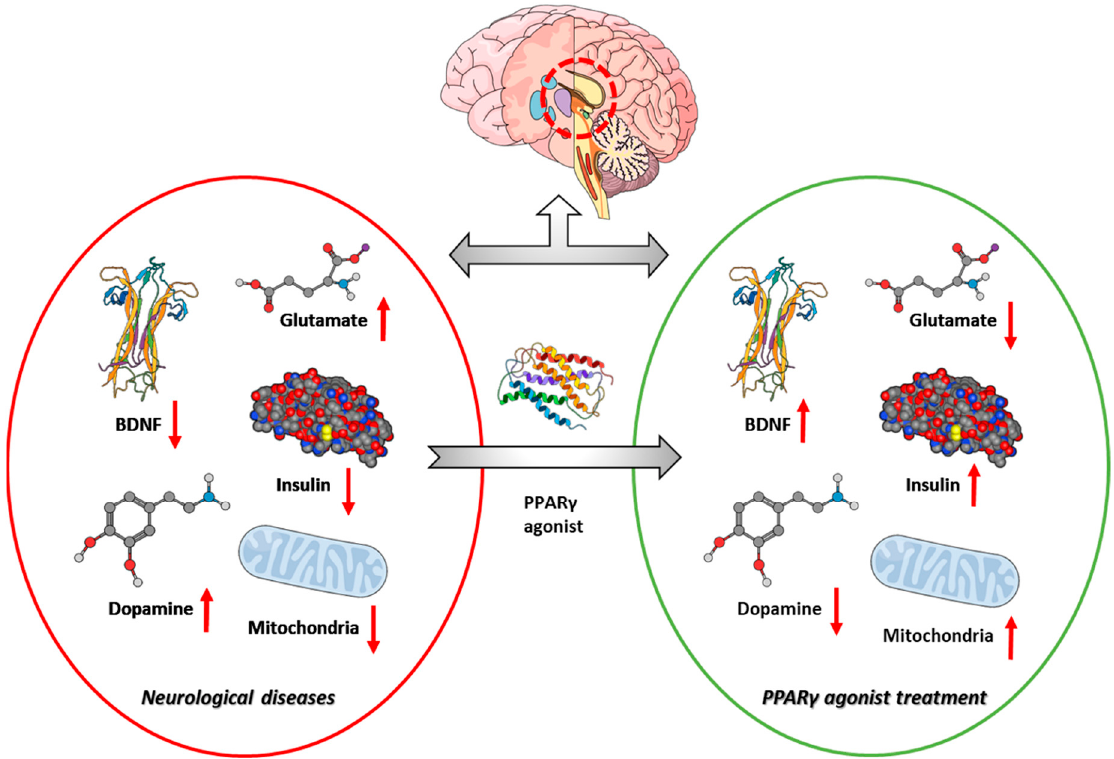
Figure 2. Roles of activated peroxisome proliferator-activated receptor γ (PPAR γ ) in the rescue of cognitive performance. BDNF: brain-derived neurotrophic factor.